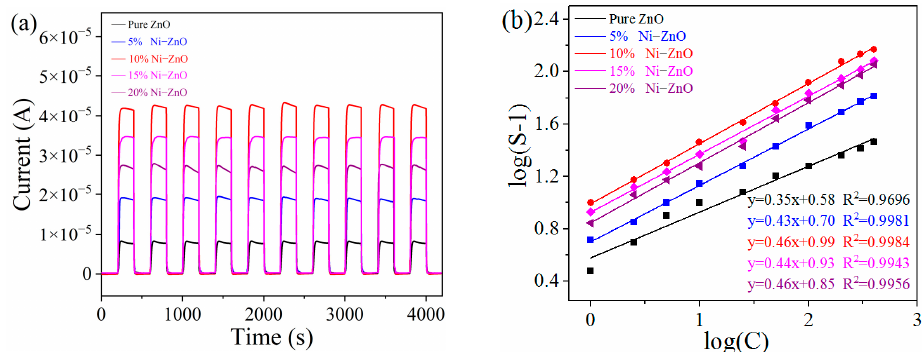
Figure 8. ( a ) Current change curves of the 10% Ni-ZnO sensor upon exposure to 100 ppm formal- dehyde vapor for 10 tests at the optimal working temperature (220 °C). ( b ) Linear relationship of the response to different concentrations of formaldehyde.